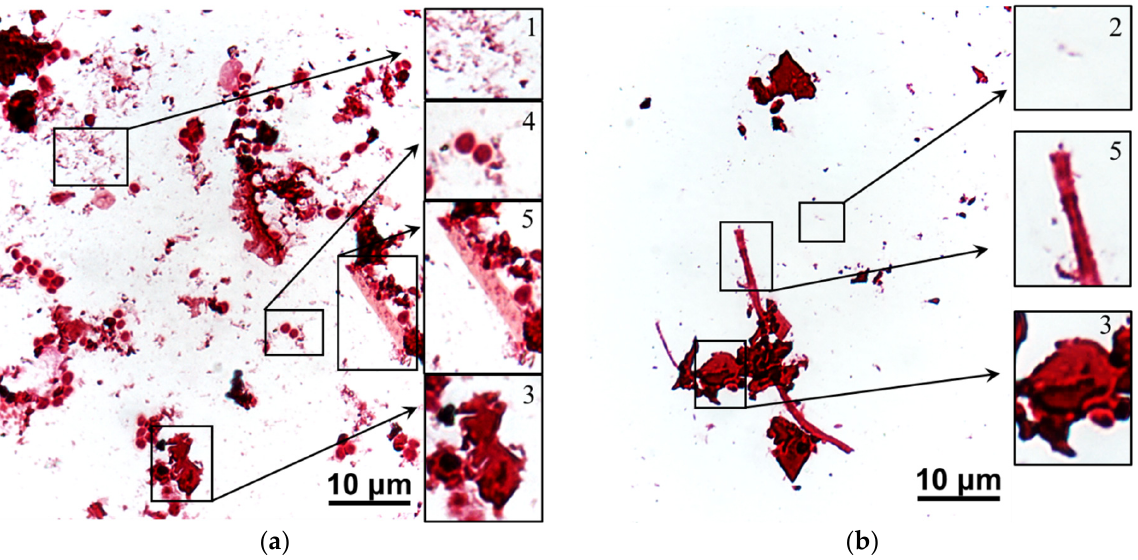
Figure 14. Stained scrapings from the surface of CJMC-5 cation-exchange membrane after cleaning in operando without ( a ) and with ( b ) electric field application. Legend: 1 is bacterial conglomerates, 2 is bacterial cells, 3 is fungal conglomerates, 4 is rod-shaped bacteria.